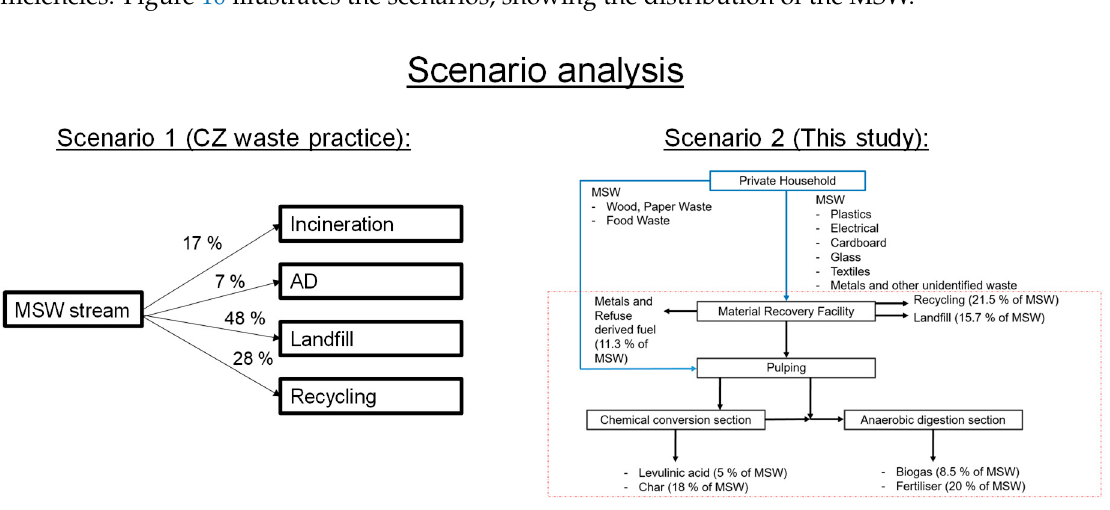
Figure 10. Workflows for MSW treatment under comparison.